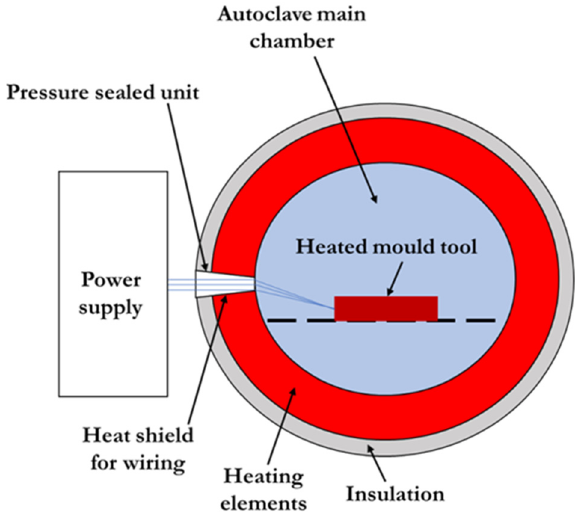
Figure 10. Schematic of the power-supply mechanism for the heated mould tool inside the autoclave chamber (redrawn from [18]).